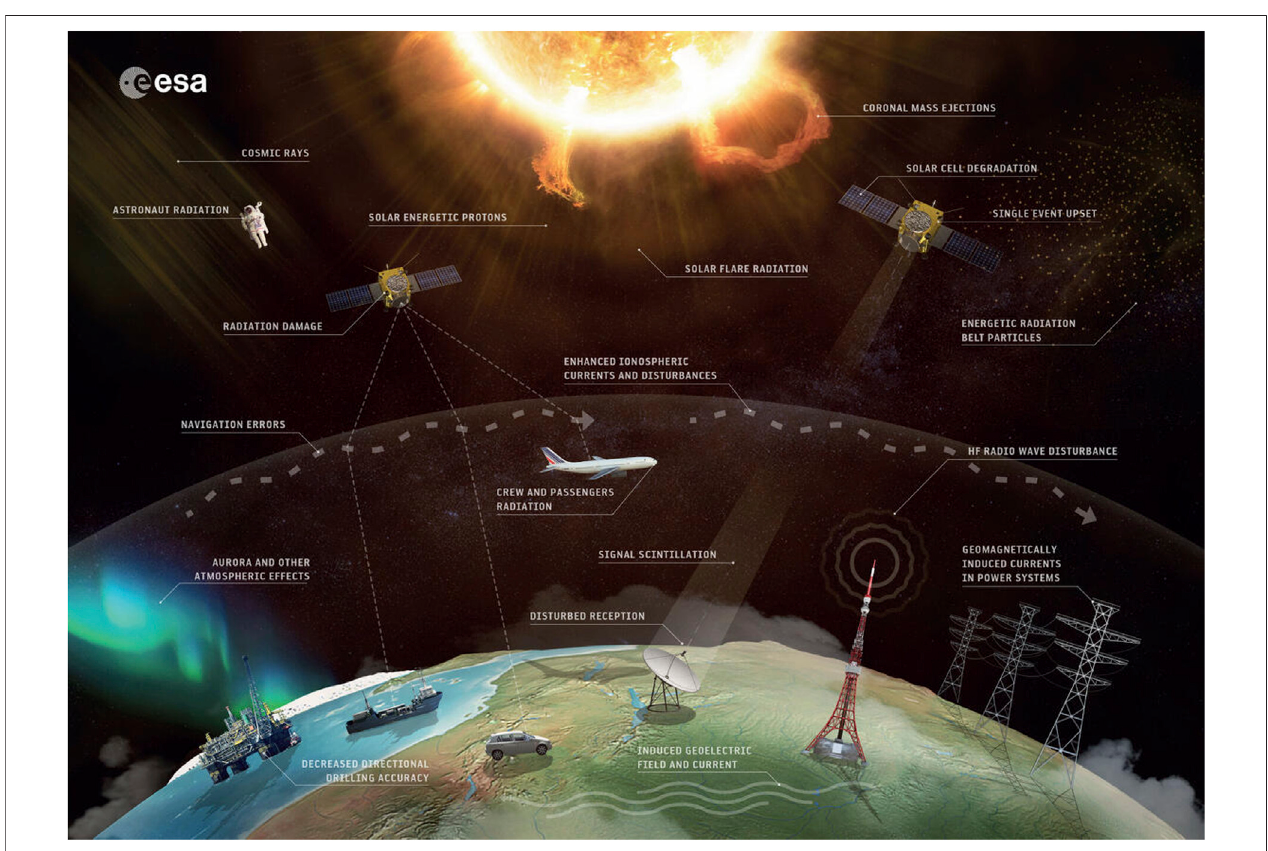
FIGURE 15 | Illustration of the many societal effects that space weather can cause. Effects include damage to electronic in orbit around Earth, radiation risks to astronauts and airline passengers, telecommunication disturbances such as radio and GPS blackouts, and risks to power grid disruptions Cranmer et al. (2017). Image Credits: European Space Agency